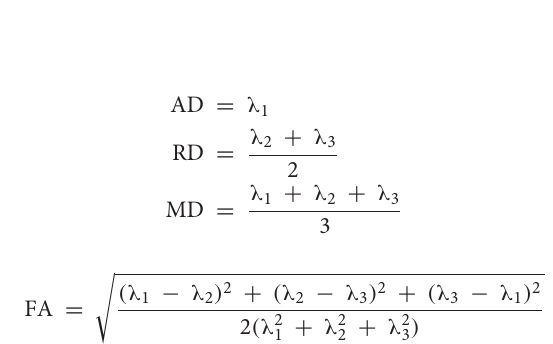
FIGURE 2 | White matter fiber tracts showing significantly lower MD values in the intervention group than in the control group (displayed in blue). The results are overlaid on the mean FA skeleton (shown in green) and the standard MNI152 T1 1-mm 3 brain template. The value of z in the horizontal plane represents the MNI z -coordinate. Abbreviation: FA, fractional anisotropy; L, left; MD, mean diffusivity; MNI, Montreal Neurological Institute; R,